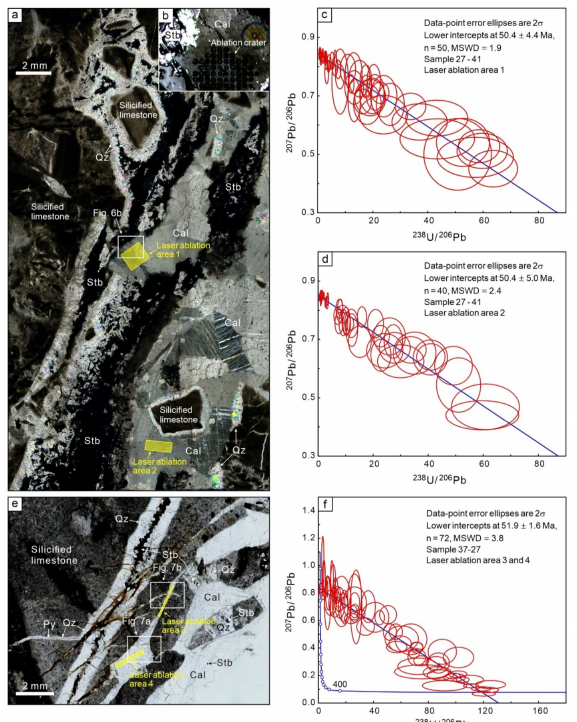
Figure 6. ( a ) Photomicrograph showing the occurrence of stibnite, calcite, and quartz in quartz- stibnite vein (sample 27–41, under plane-polarized light) from the Xikuangshan Sb deposit, and the areas of LA-MC-ICP-MS calcite U-Pb isotope analyses (yellow area). ( b ) Representative laser ablation craters. ( c , d ) Tera–Wasserburg concordia diagrams of syn-stibnite calcite crystals in the laser ablation areas 1 and 2, respectively. ( e ) The mineral assemblage in quartz-stibnite vein (sample 37–27, under plane-polarized lights), and the areas analyzed for U-Pb dating (yellow area). ( f ) Tera–Wasserburg concordia diagram of syn-stibnite calcite crystals in the laser ablation areas 3 and 4. Error ellipses are at 2 σ . Py = pyrite, other abbreviations as in Figure